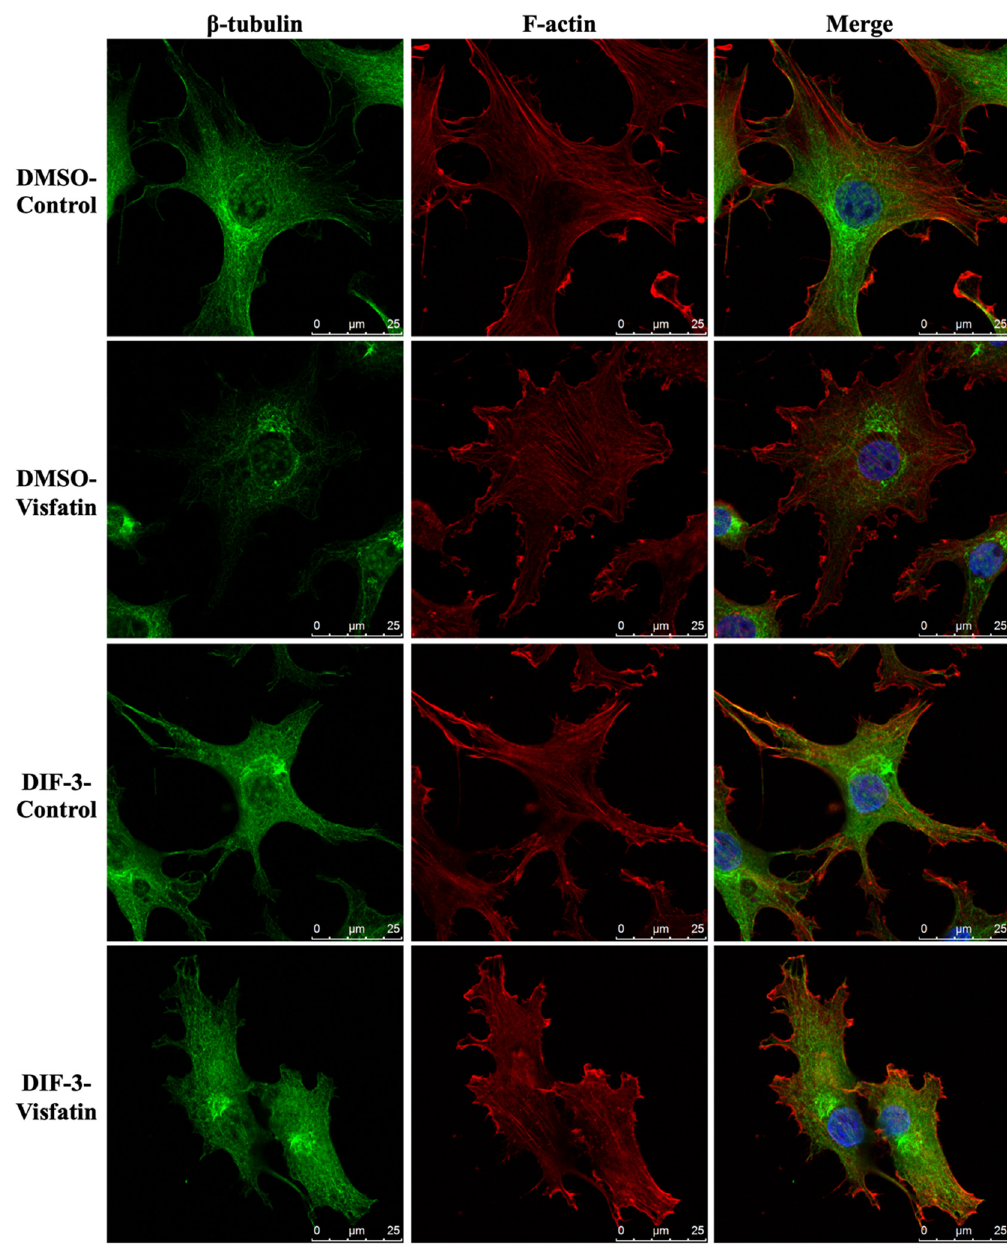
Figure 7. GSK3 β inactivation regulates visfatin ‐ induced damage of the microfilament and microtubule networks in human primary chondrocytes. Human primary chondrocytes were pretreated with DMSO or DIF ‐ 3, a GSK3 β activator, for 1 h and then kept as controls (CL) or treated with 5 μ g/mL of visfatin (Vis) for 4 h. The microfilament and microtubule networks were stained with Alexa Fluor 633 ‐ phalloidin (F ‐ actin, red color) and β‐ tubulin ‐ specific antibody with Alexa Fluor 488 ‐ 2nd antibody (green color), respectively. The nucleus was stained with DAPI. The fluorescent images were acquired on Leica TCS SP5 II confocal microscope. The scale bar is 25 μ m with 5 μ m intervals.